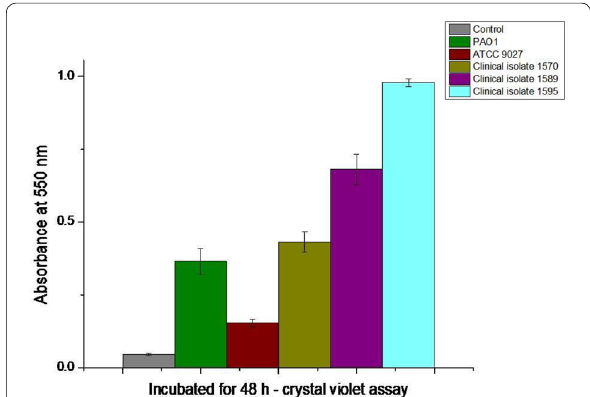
Fig. 6 Biofilm forming assay for P. aeruginosa strains in nutrient broth for 48 h. Control is un-inoculated nutrient